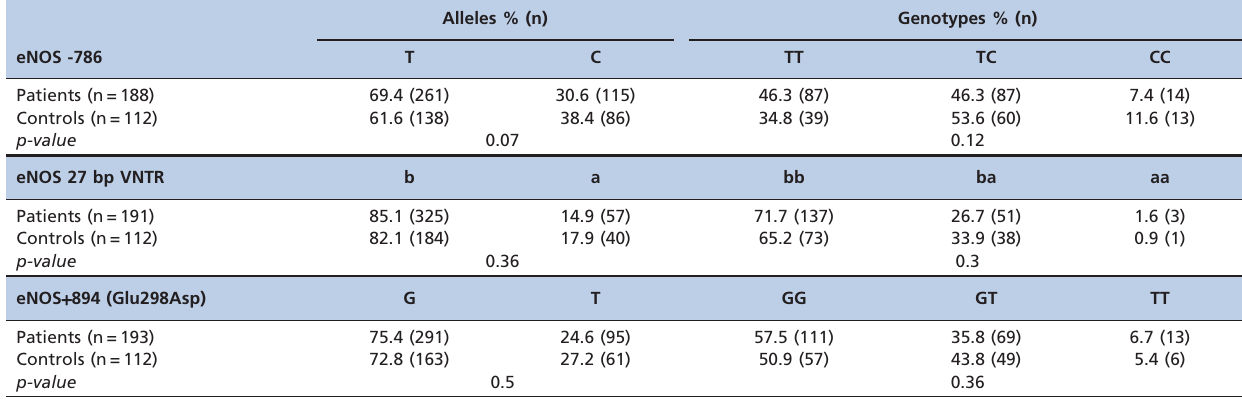
Table 2 - Allele and genotype frequencies of the eNOS gene polymorphisms in patients with AS and healthy controls. Alleles %